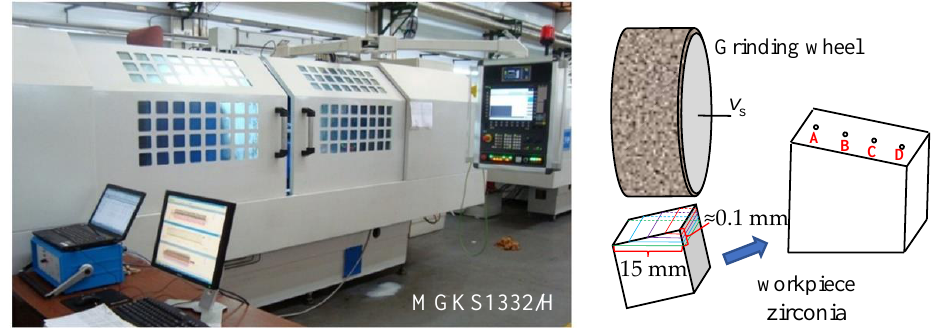
Figure 3. Experimental setup for high-speed grinding.